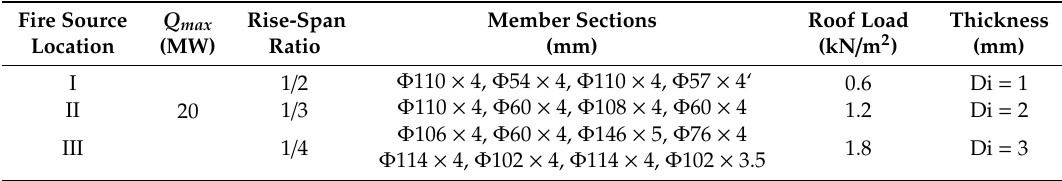
Table 4. Parameters of single-layer cylindrical reticulated shell.